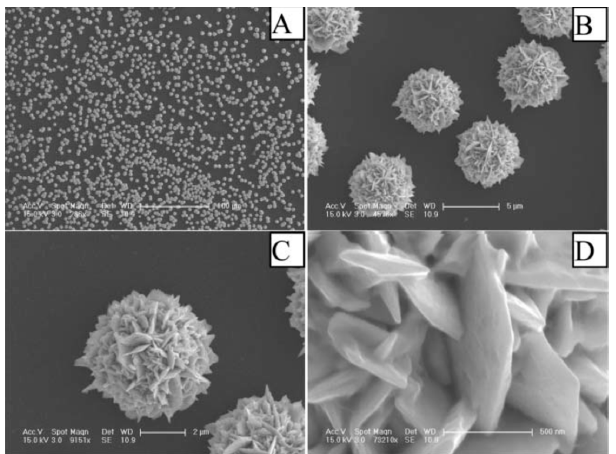
Figure 2. Typical FE-SEM images of the hierarchical flowerlike Au microstructures deposited on ITO substrate at different magnifications; The scale bars for ( A – D ) are 100, 5, 2 μ m and 500 nm, respectively. Images reproduced from [16] by permission of The Royal Society of Chemistry.